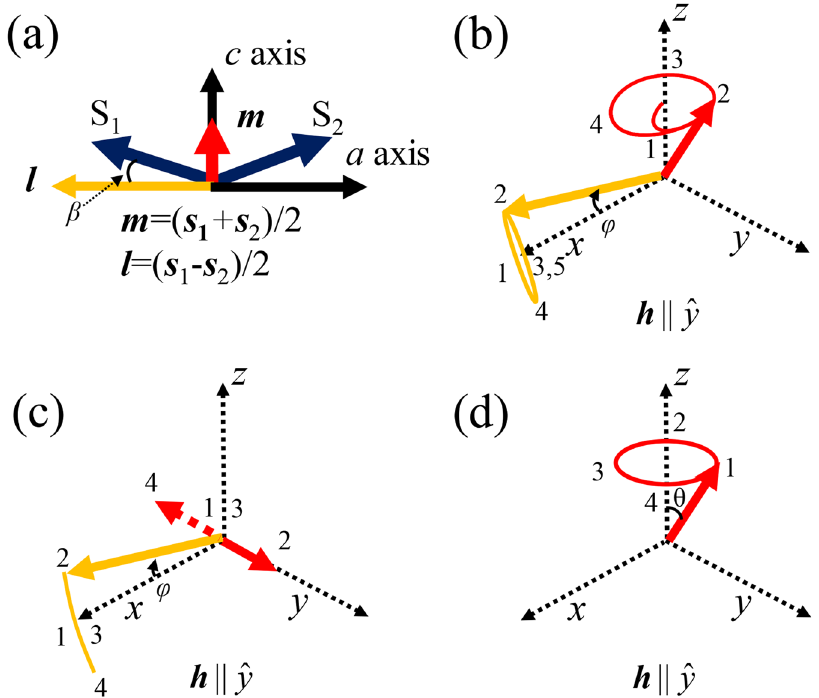
Figure 1. Spin configuration of a canted antiferromagnet in equilibrium and schematic for the excitation modes in various magnetic systems. ( a ) Equilibrium state of a canted antiferromagnet. ( b–d ) Excitation modes when the incident magnetic pulse is applied in the y -direction: ( b ) Elliptical precession in a canted antiferromagnet. ( c ) Fluctuating motion in a simple antiferromagnet and ( d ) ferromagnet